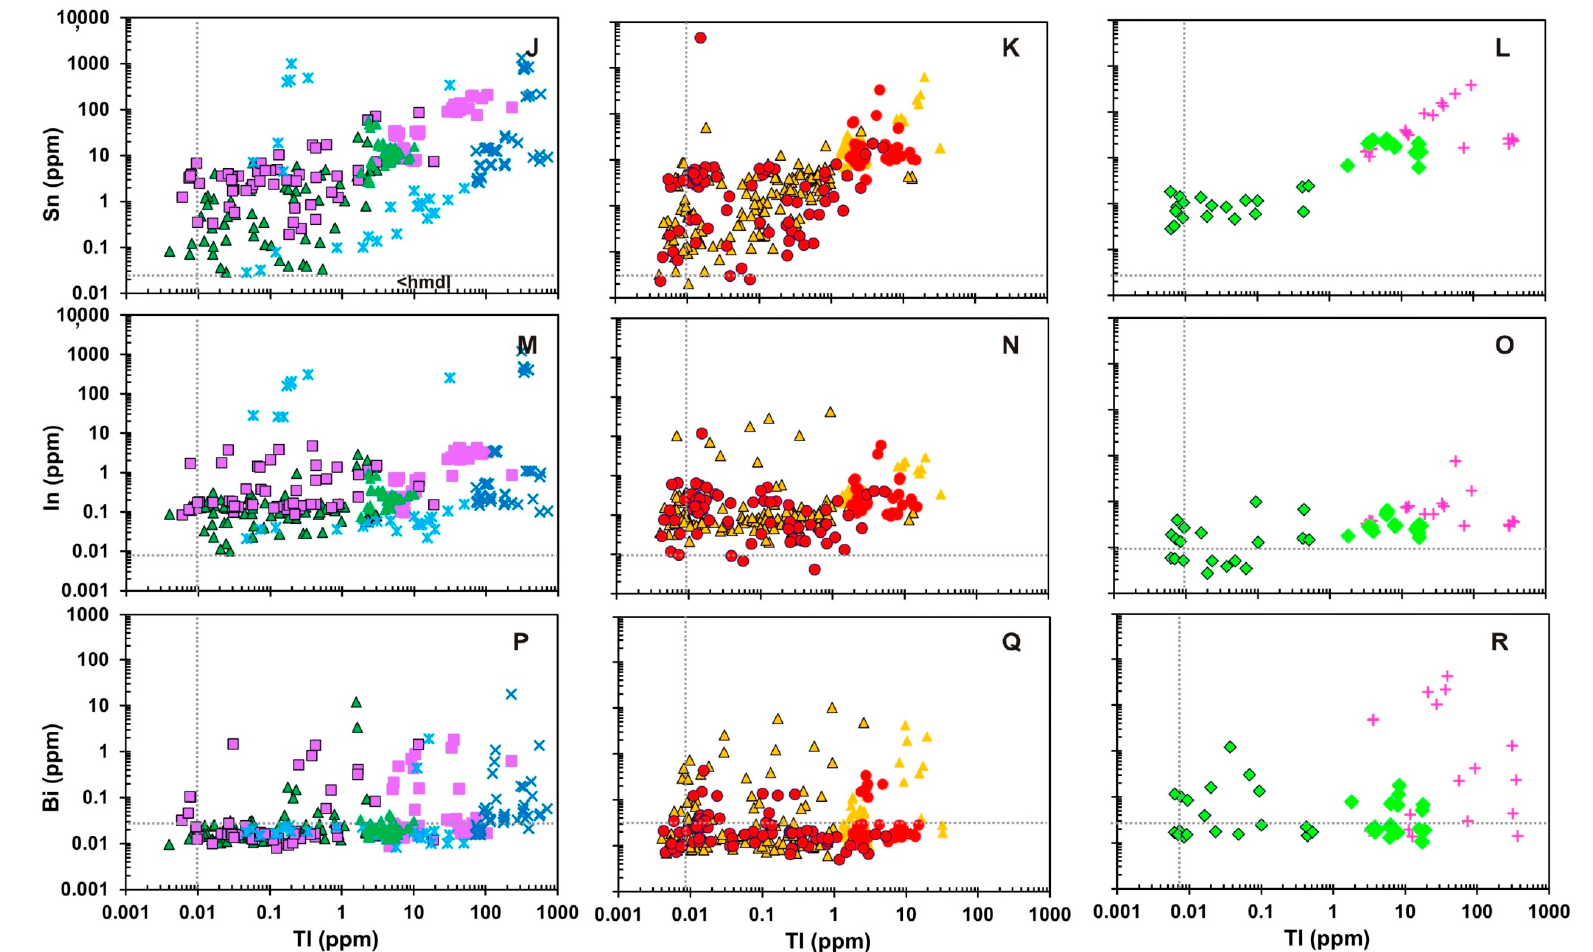
Figure 8. Binary plots of Tl (in ppm) vs. Sb, ( A , B and C ); Hg, ( D , E and F ); As, ( G , H and I ); Sn (J, K and L); In, ( M , N , and O ); and Bi, ( P , Q and R ), for chlorite and white mica from selected massive sulfide deposits of the BMC as determined by LA-ICP-MS during this study (see Supplementary Tables S6 and S7). The dotted lines are equivalent to ½ of the mean detection limit (<hmdl of the presented element).